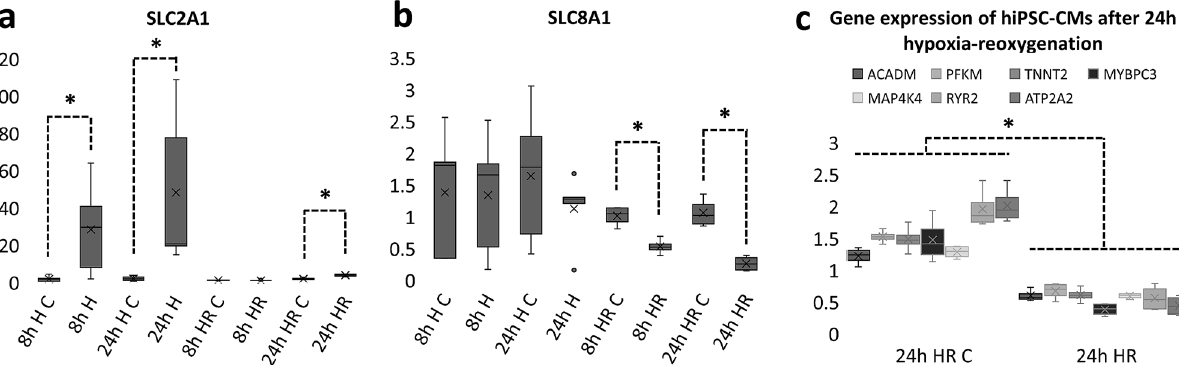
Figure 5. ( a ) SLC2A1 expression in hiPSC-CMs after 8 and 24 h hypoxia in control (C, n 8h = 6, n 24h = 5) and hypoxia (H, n 8h = 5, n 24h = 6) samples as well as 8 and 24 h hypoxia-reoxygenation (HR) in control (C, n 8h = 4, n 24h = 4) and hypoxia (H, n 8h = 4, n 24h = 4) samples from qPCR analysis presented as mean + standard deviation. SLC2A1 encodes glucose transporter 1 and is related to glucose uptake of the cells. As can be seen,